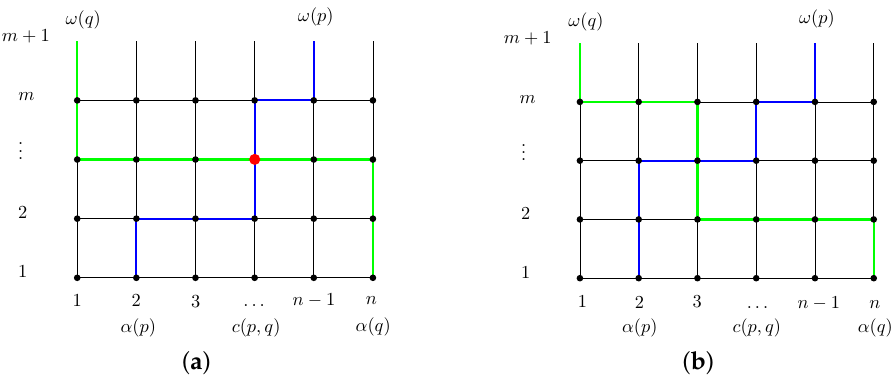
Figure 1. A sample grid graph with two conflicting vehicles routed on: ( a ) paths colliding in the red node; ( b ) collision-free